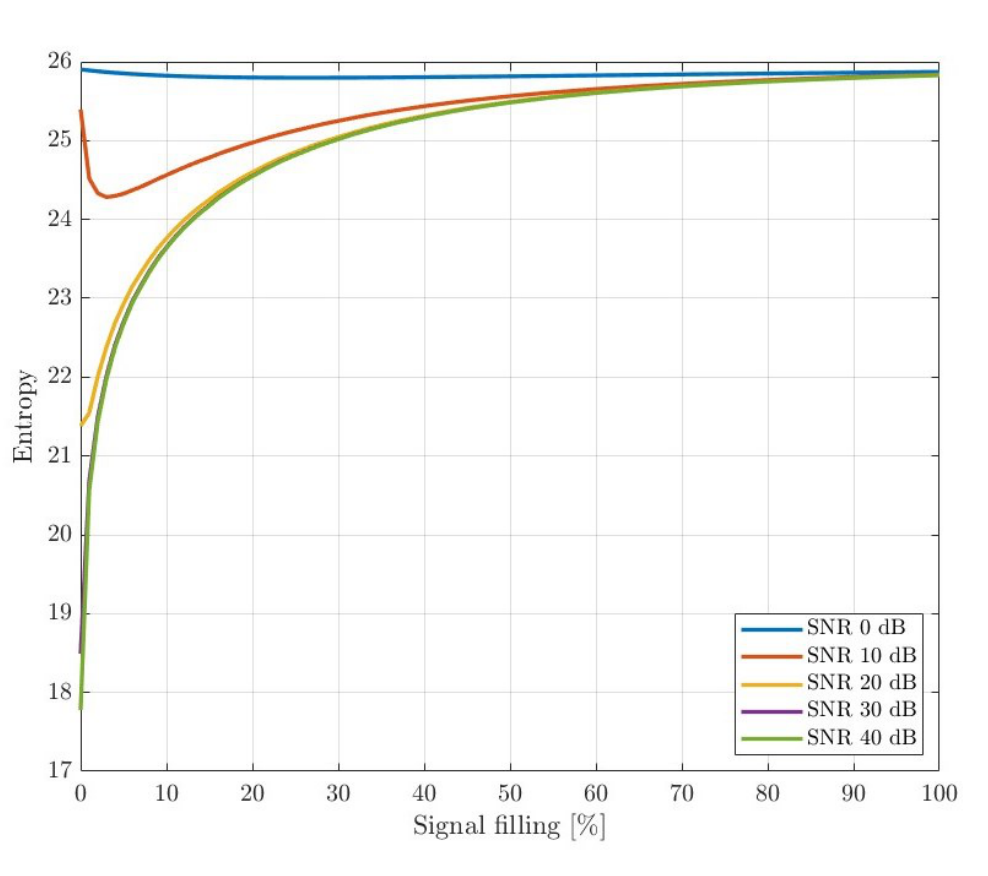
Figure 13. Plot entropy—resource